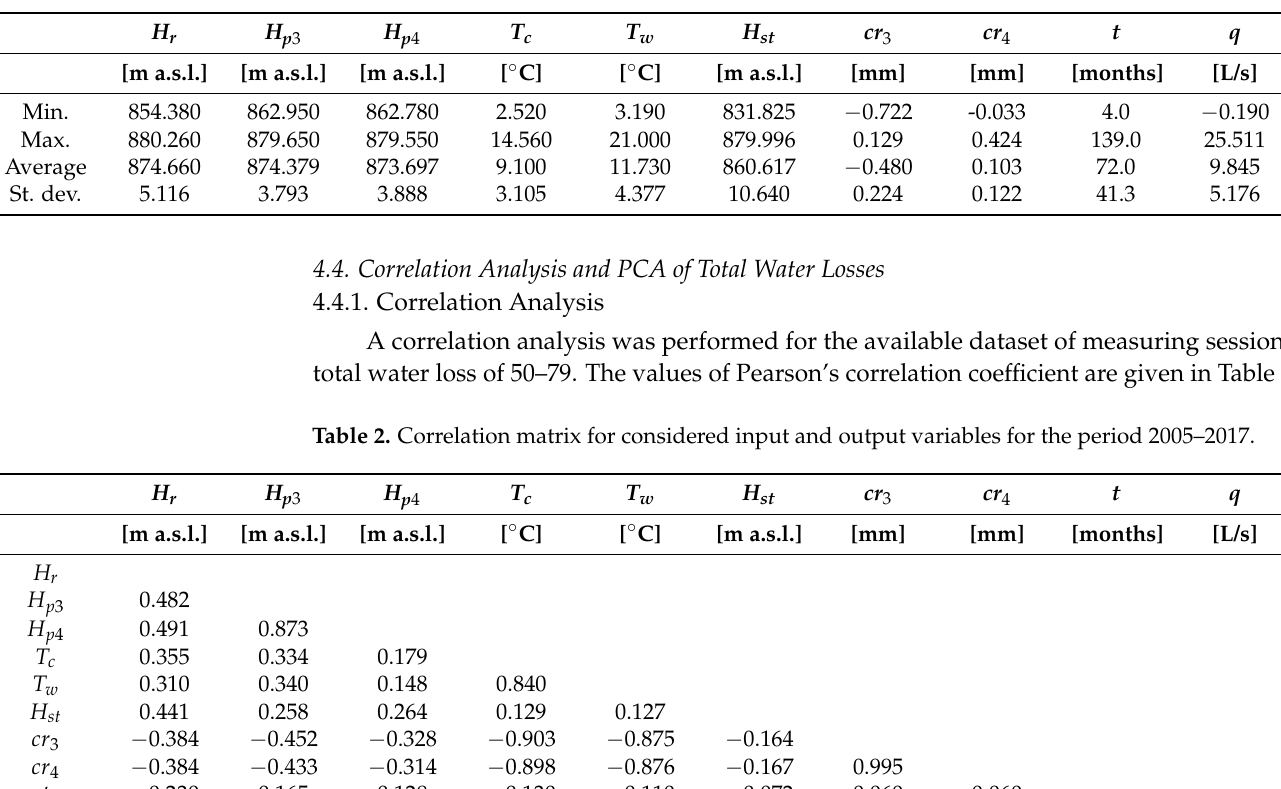
Table 1. Descriptive statistics of measured values for measurement sessions 50–79.